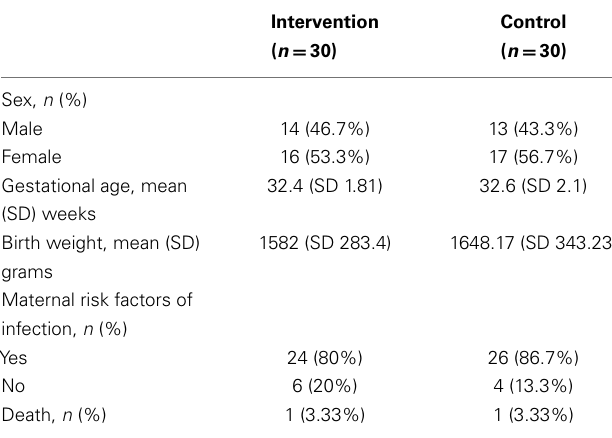
Table 1 | Baseline characteristics of subjects .